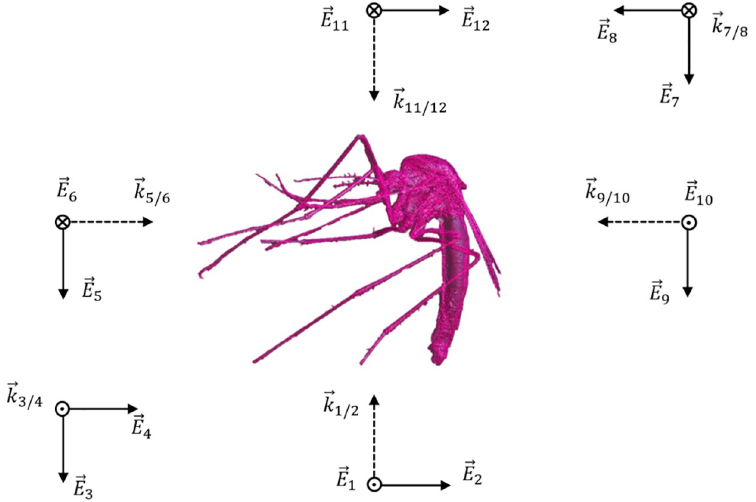
Fig 1. An overview of 12 plane waves in the simulation set up. 6 directions × 2 polarizations. The wave vector is indicated with the dotted arrow and the electric field with a solid arrow.